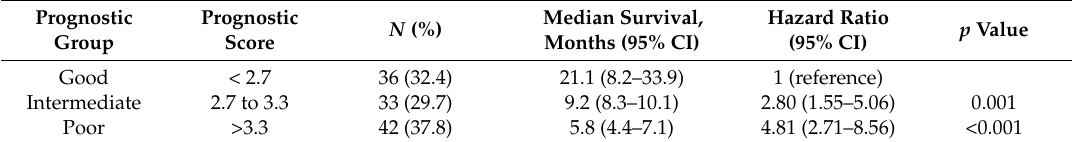
Table 4. Survival time of patients by prognostic group.